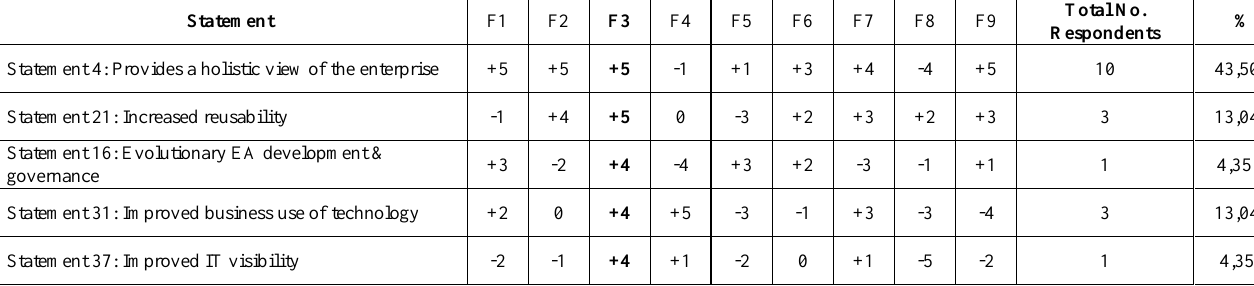
Table 7: Factor 3. Evolutionary reuse overseer, key items